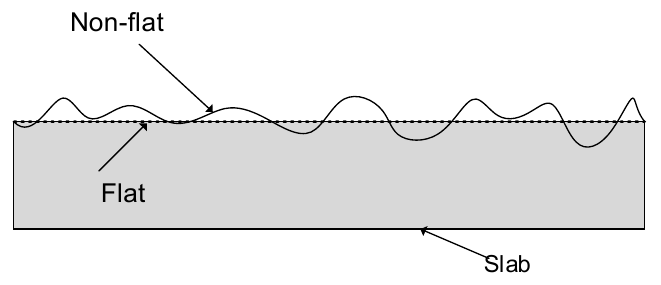
Figure 1. Illustration of flat and non-flat surfaces in the cross-section view of a